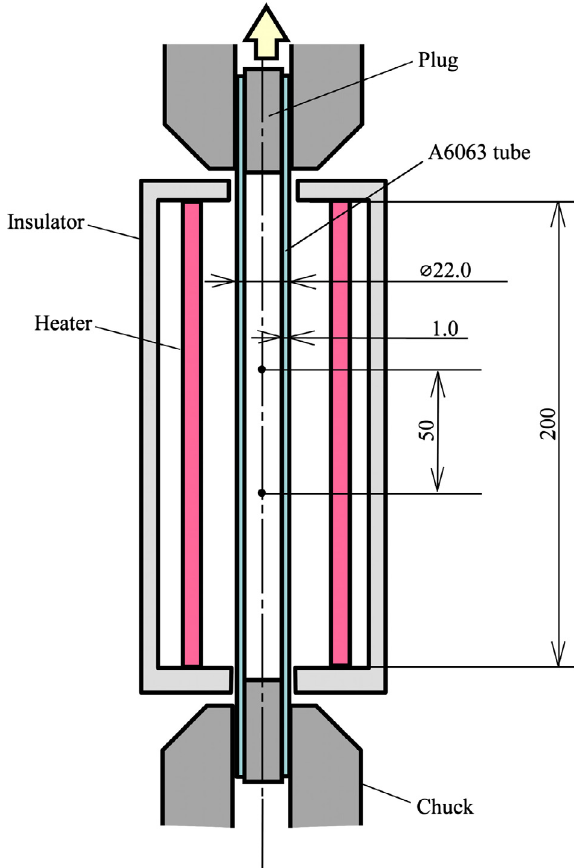
Figure 3. High temperature tensile test of A6063 tube.